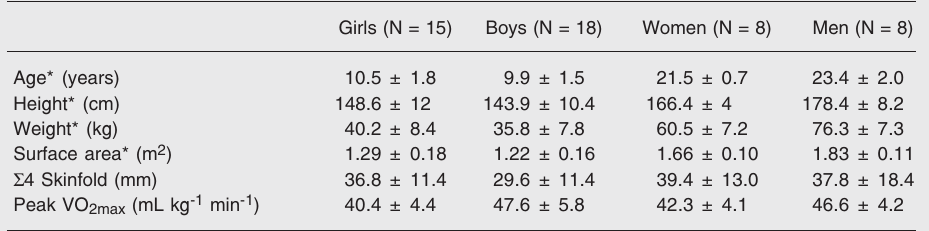
Table 1. Physical and physiological characteristics of the